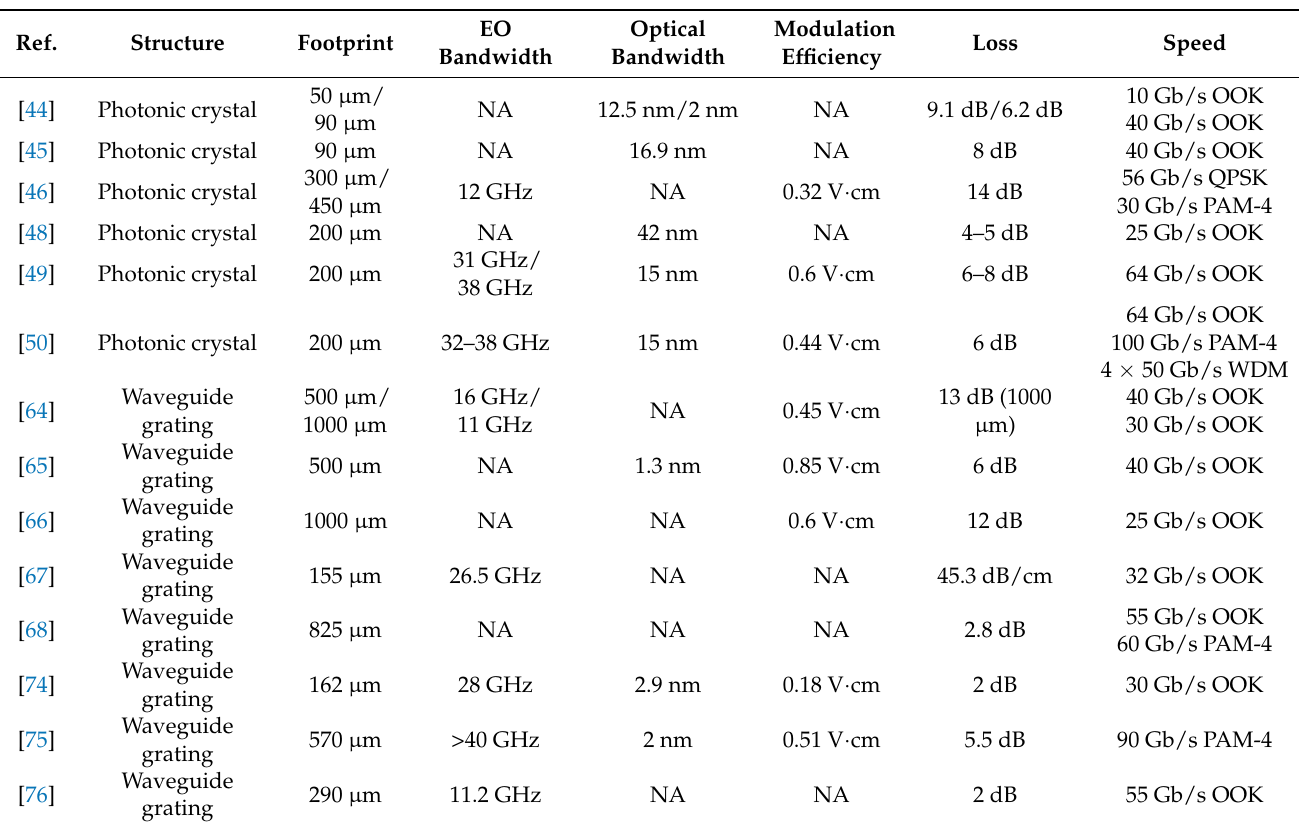
Table 1. Comparison for experimental results of representative silicon slow-light modulators.